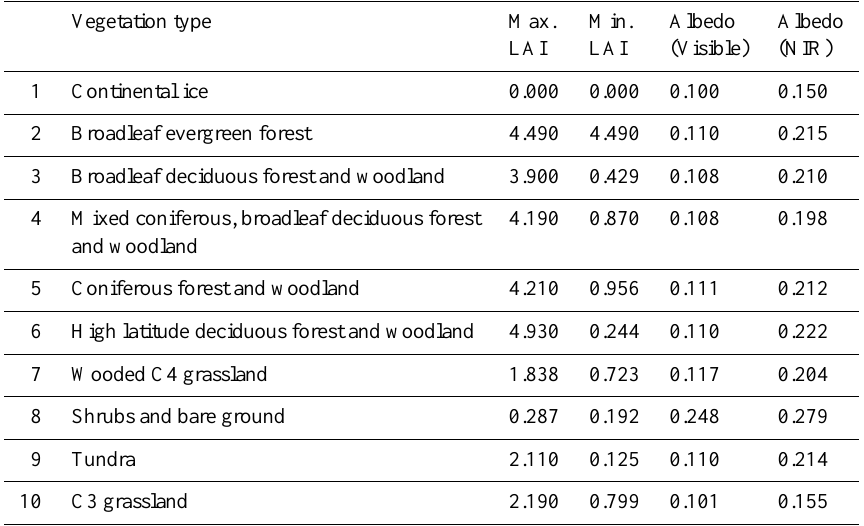
Table 3. Maximum and minimum values of the leaf area index (LAI) and soil albedo values for visible and near infrared wavelength bands corresponding to each vegetation type in the mid-Pliocene experiments.